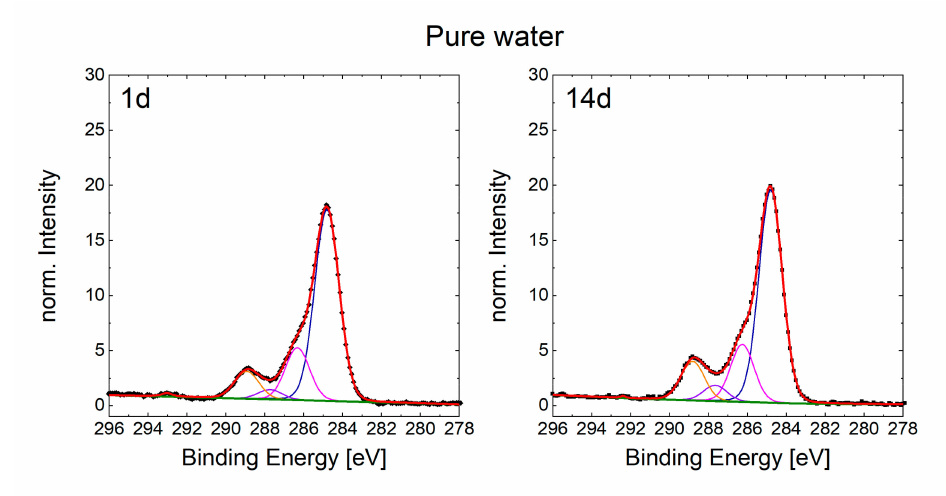
Figure A1. C 1s spectra of structured sample 1 and 14 days after cleaning with pure water.